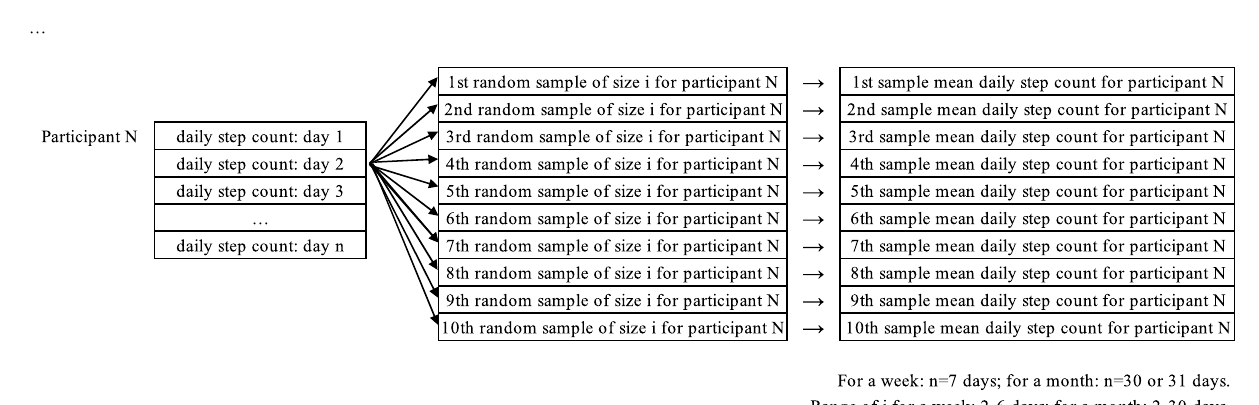
Figure 1. Data sampling procedures for a study time window and sample size of i measurement